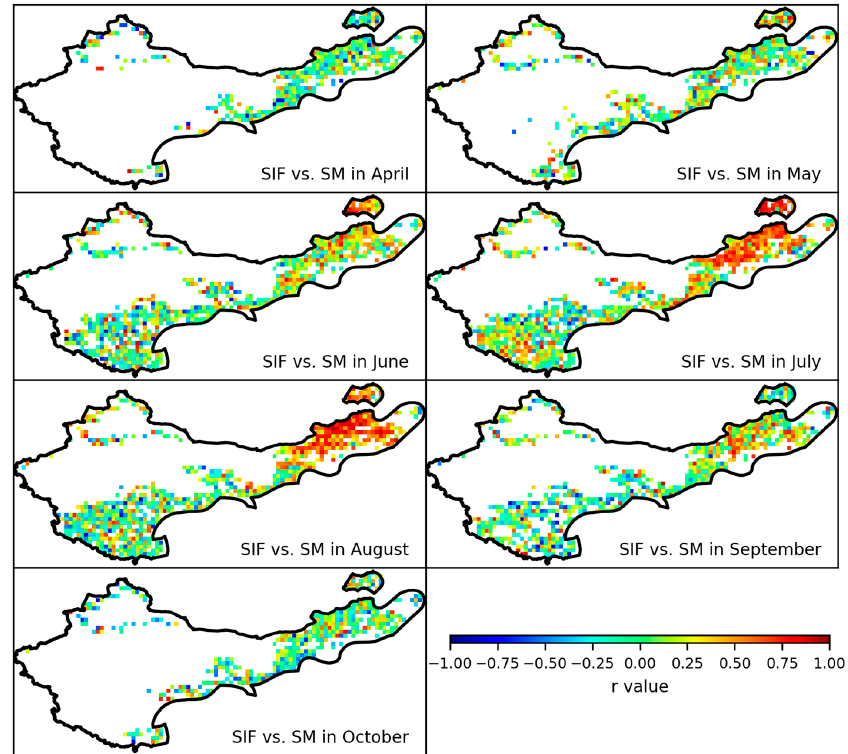
Figure 6. Spatiotemporal distribution of the correlation coefficients between SIF and soil moisture (SM) in each month of growing season. Pixels with white color mean non-grassland or missing data.